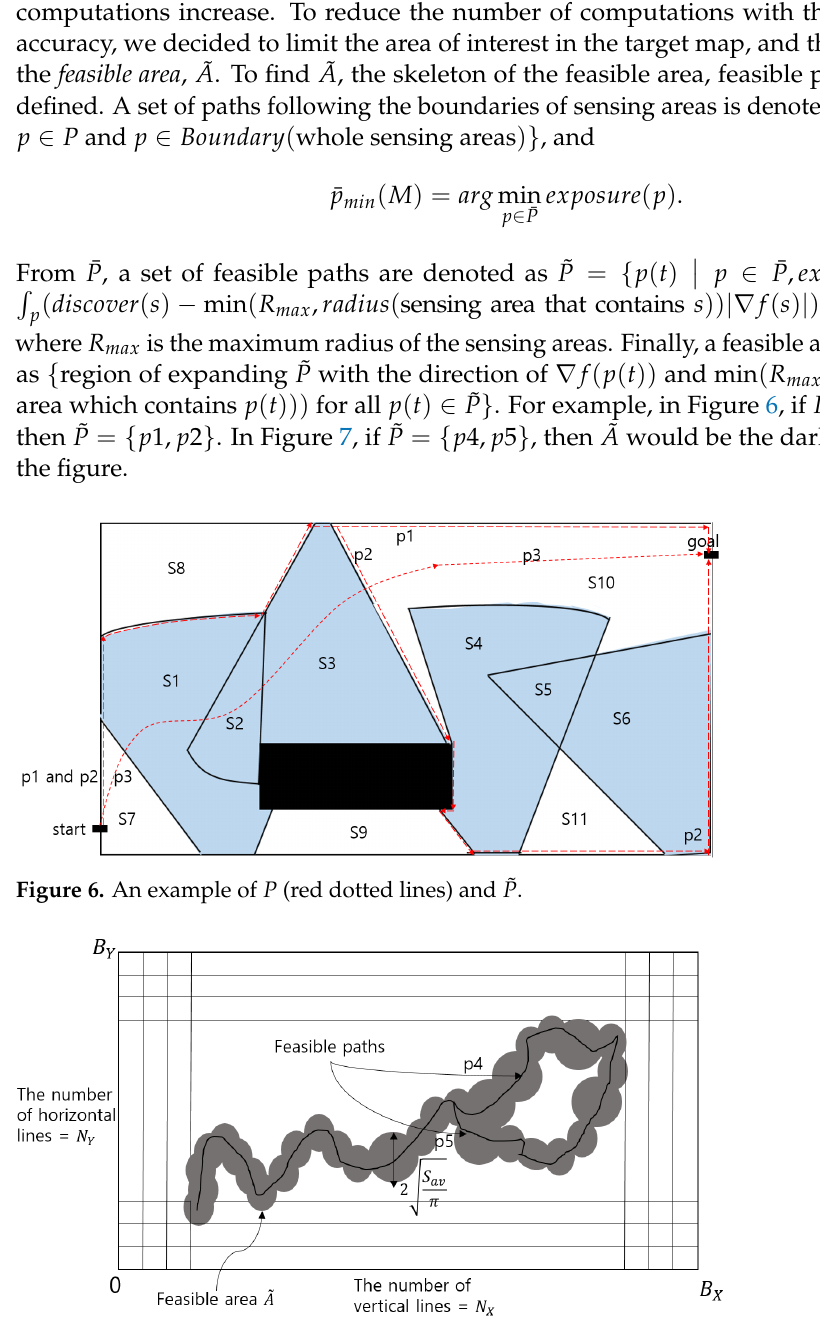
Figure 7. An example of ˜ P and ˜ A